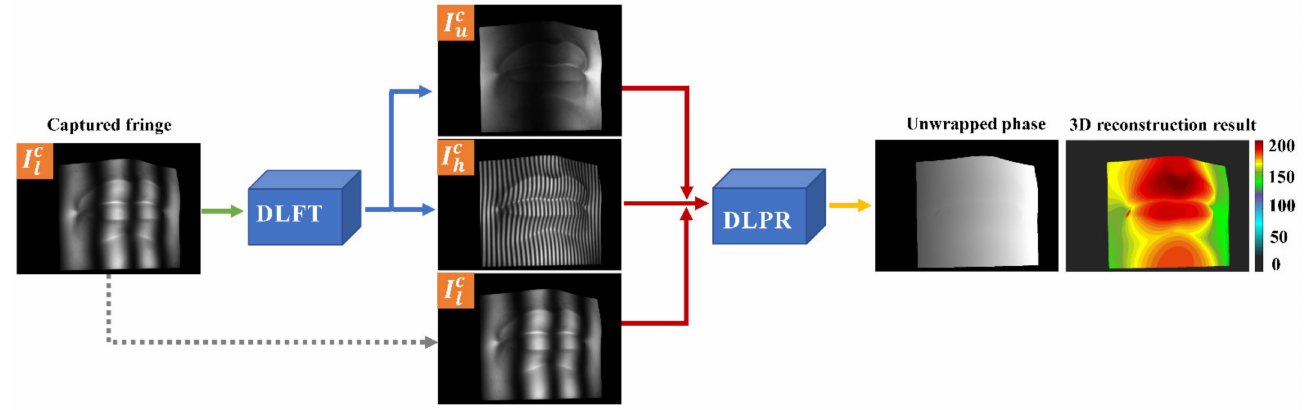
Figure 1. The implementation process of the proposed SAPR-DL